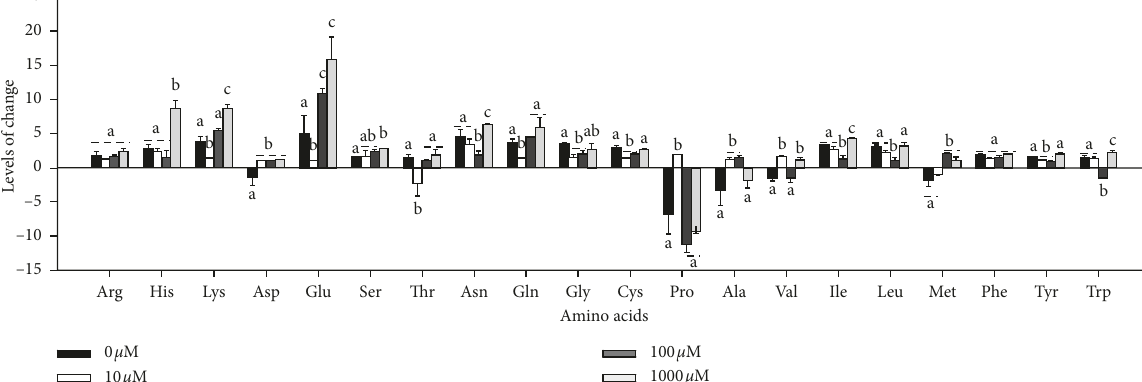
Figure 3: Exogenous application of salicylic acid on accumulation levels of amino acids in plants of Buddleja scordioides not subjected to stress. Precursor ion ( m/z + ) and transitions registered for each amino acid were